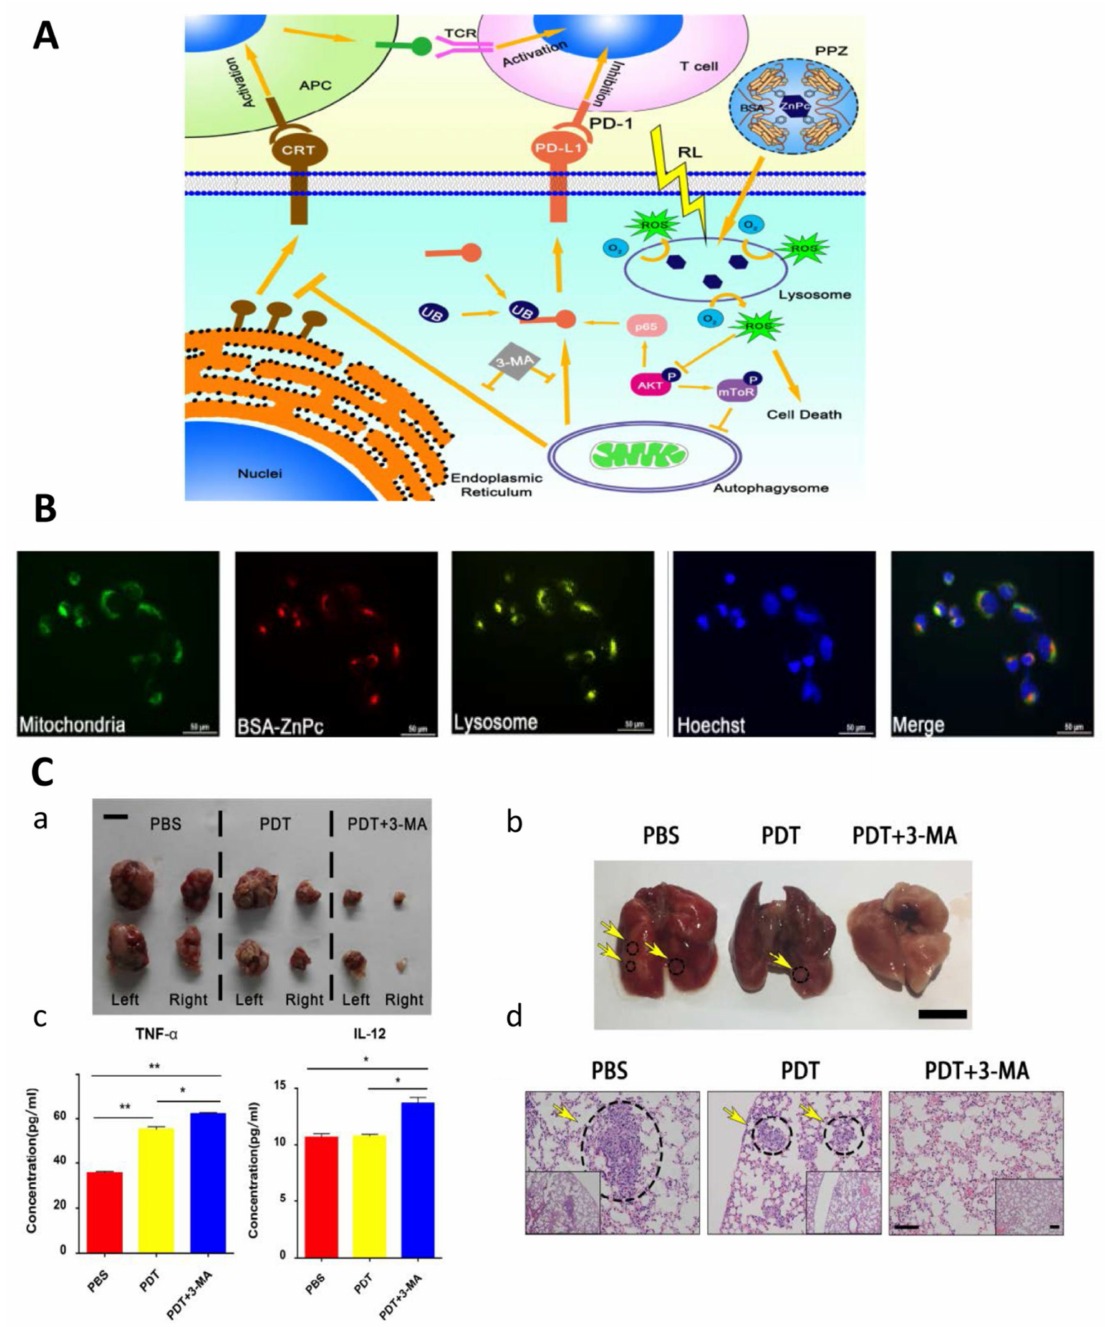
Figure 3. ( A ) Schematic overview of the anti-tumor immune response in osteosarcoma induced by the combination of PDT and 3-MA. ( B ) PDT using BSA-ZnPc induced autophagy in osteosarcoma cell lines. The distribution of mitochondria, lysosomes, and BSA-ZnPc in MNNG/HOS cells after treatment with BSA-ZnPc for 24 h (sacle bar = 50 µ m). ( C ) Combined therapy of PDT and 3-MA inhibited tumor growth in a distant metastasis subcutaneous tumor model. ( a ) The tumors